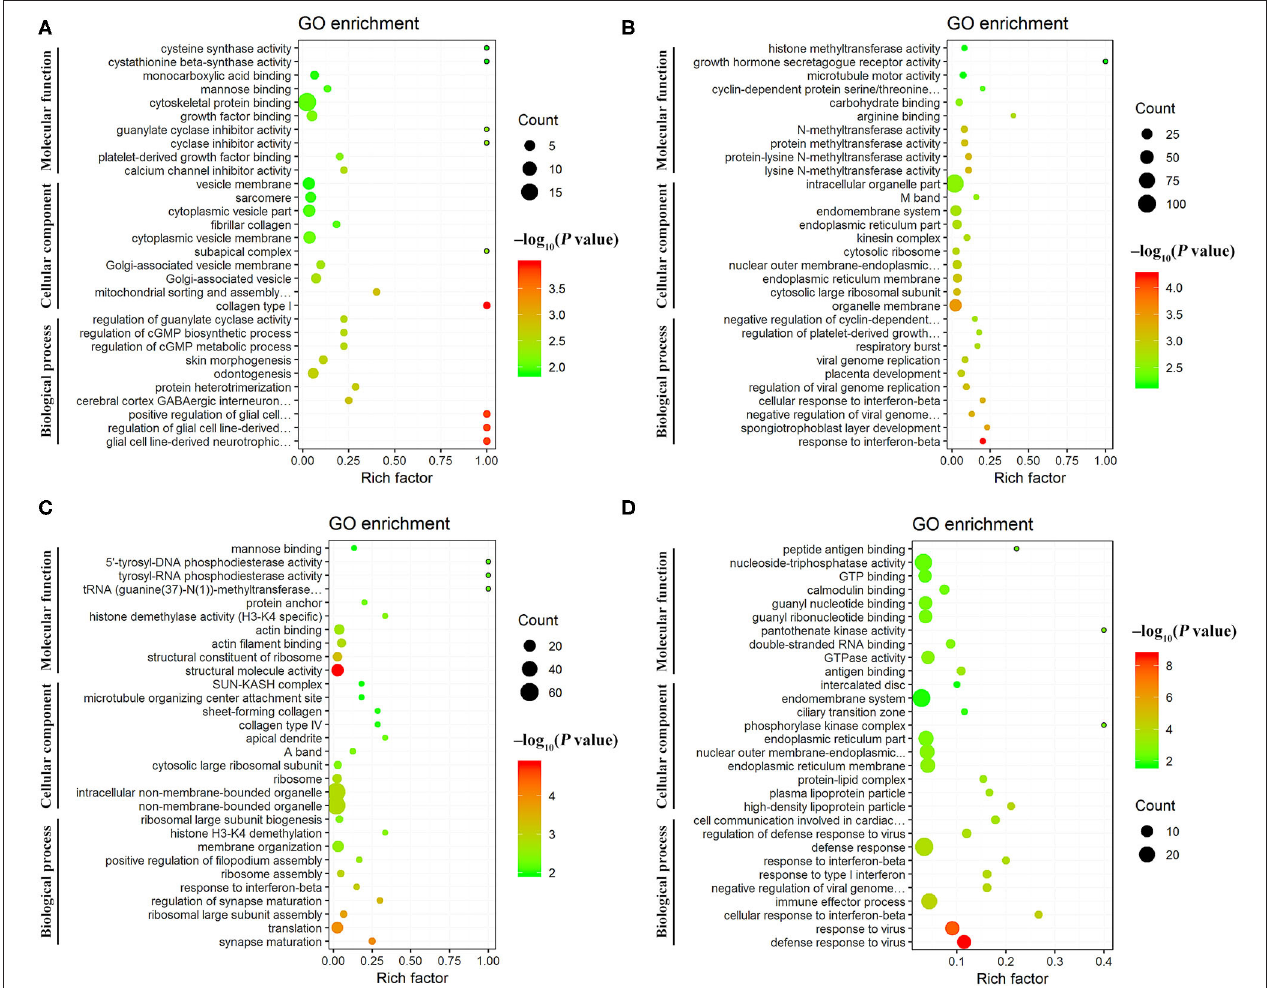
FIGURE 5 | Scatter plots of the top 30 enriched Gene Ontology (GO) terms (including biological process, cellular component, and molecular function categories) of the DEmRNAs at (A) 12 hpi, (B) 24 hpi, (C) 96 hpi, and (D) 36 dpi. The X-axis label represents the rich factor; the Y-axis label shows the GO terms. The rich factor reflects the proportion of DEmRNAs in a given GO term. The greater the rich factor, the greater the degree of enrichment. The color of the dots represents the enrichment score [–log 10 ( P -value)], where red color indicates high enrichment, while green color indicates low enrichment. Dot size represents the number of DEmRNAs in the corresponding GO term (bigger dots indicate larger DEmRNA